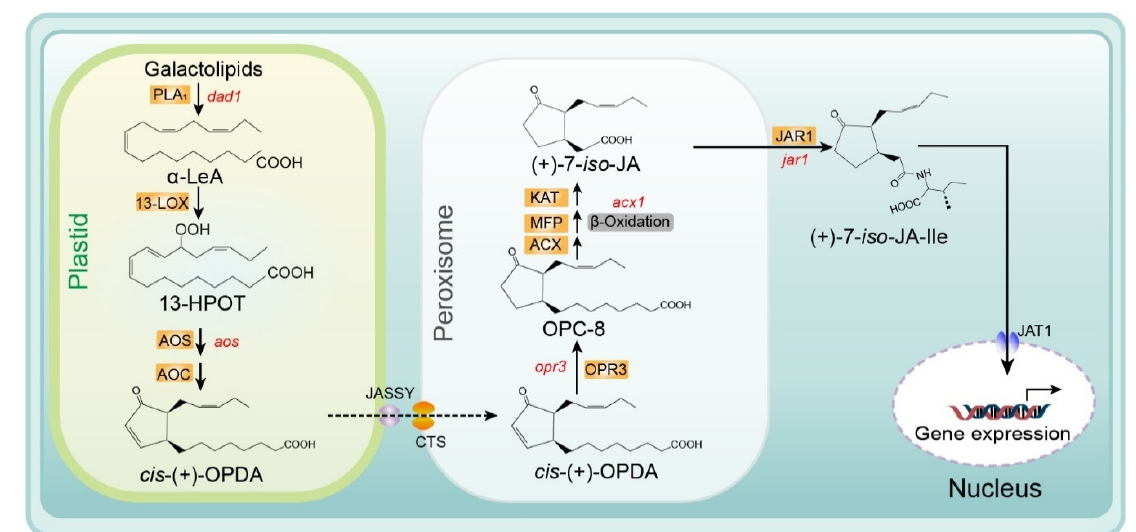
Figure 2. Biosynthesis of JA/JA-Ile initiated by the release of α -linolenic acid from galactolipid. De novo synthesis of JA occurs in the plastids, peroxisomes, and cytoplasm, and JA-Ile is then transported to the nucleus for gene expression. Major genes are indicated in red and enzyme names are highlighted in orange. Abbreviations for compounds: α -LeA, α -linolenic acid; 13-HPOT, (13S)-hydroperoxyoctadecatrienoic acid; cis- (+)-OPDA, cis- (+)-12-oxophytodienoic acid; OPC-8, 3-oxo-2- (2-pentenyl)-cyclopentane-1-octanoic acid; (+)-7-iso-JA, jasmonic acid; (+)-7-iso-JA-Ile, jasmonic acid isoleucine conjugate. Abbreviations for enzymes/proteins: PLA1, phospholipase A1; 13-LOX, 13-lipoxygenase; AOS, allene oxide synthase; AOC, allene oxide cyclase; OPR3, OPDA reductase3; ACX, acyl-CoA oxidase; MFP, multifunctional protein; KAT, 3-ketoacyl-CoA thiolase; JAR1, JA-amino acid synthetase; JASSY, a chloroplast outer membrane protein; CTS, an ABC transporter of the peroxisomal membrane; JAT1, jasmonate transporter 1 (Redrawn based on